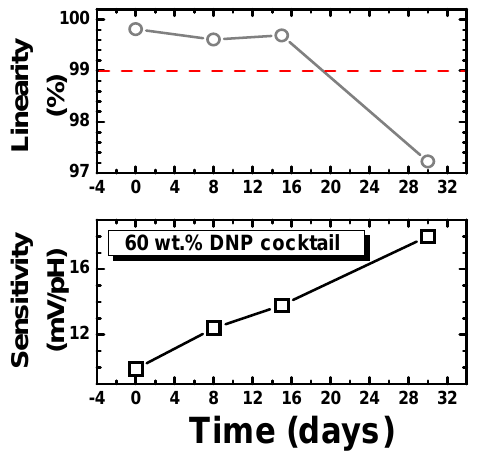
Figure 4. The time-dependent distribution of the sensitivity and linearity of REFETs with PVC membranes fabricated with a 60 wt. % DNP